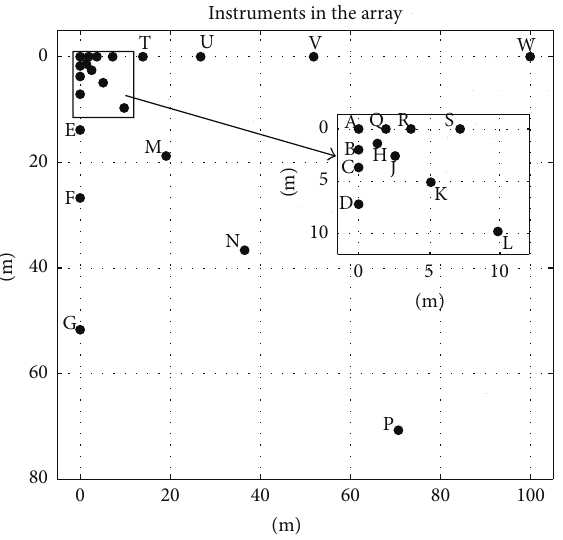
Figure 1: A schematic of the layout of the disdrometer array used for this study. Detectors near the “origin” of the array are shown in the figure inset. The one-minute summary data telegrams from each detector are transmitted via serial cable to a computer located approximately 80 meters west of detector A where they are stored for later processing and